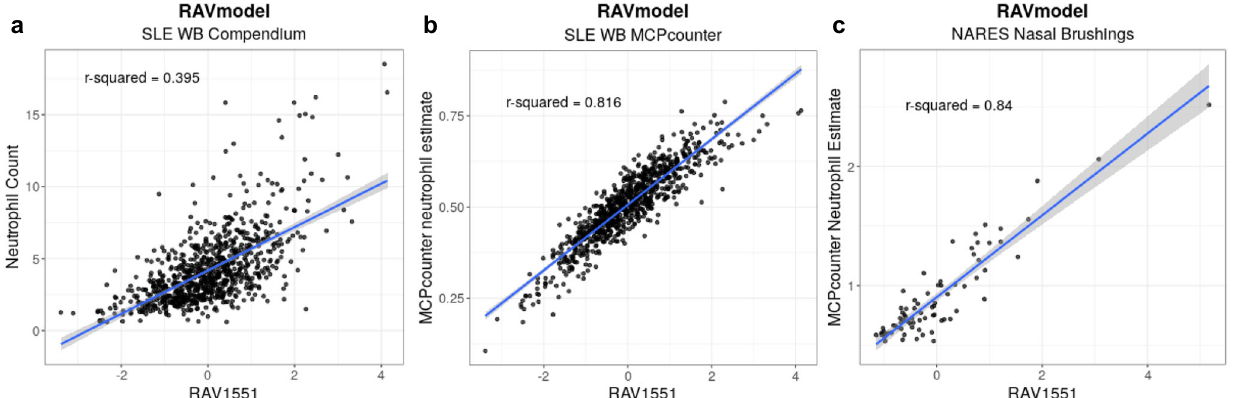
Fig. 4 Estimate biological features of a new dataset using the signatures learned from public databases. RAVs encompass biological signals applicable across different platforms and independent datasets. We demonstrate this transfer learning capacity of RAVs by identifying the neutrophil-associated RAV from systemic lupus erythematosus whole blood (SLE-WB) data and using the same RAV to analyze nasal brushing (NARES) dataset. a Neutrophil counts of 853 samples from the SLE-WB dataset were plotted against RAV1551-assigned sample scores. b Neutrophil count estimates by MCPcounter were plotted against sample scores assigned by RAV1551. c Neutrophil count of 76 NARES samples were estimated by MCPcounter and plotted against RAV1551-assigned sample scores. The shaded area is the 95% con fi dence interval for predictions from a linear